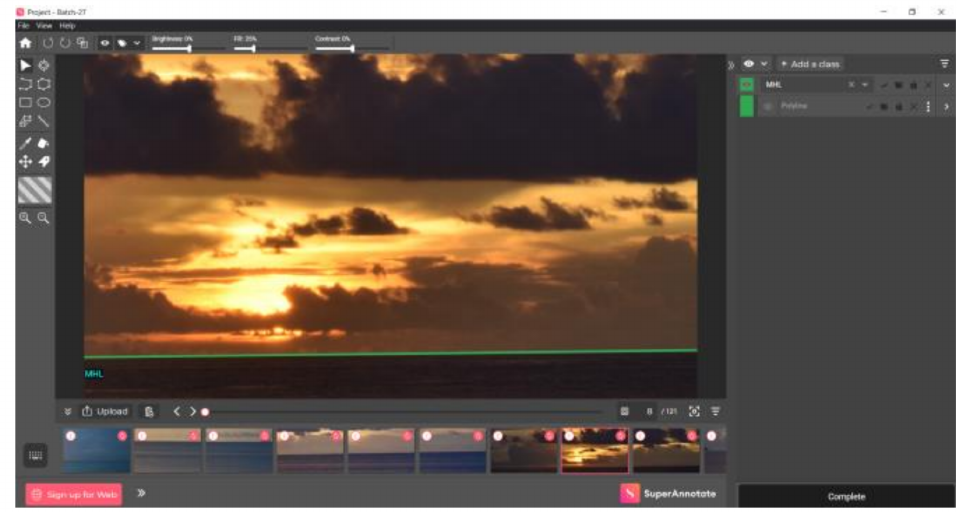
Figure 5. Image annotation using SuperAnnotate software.